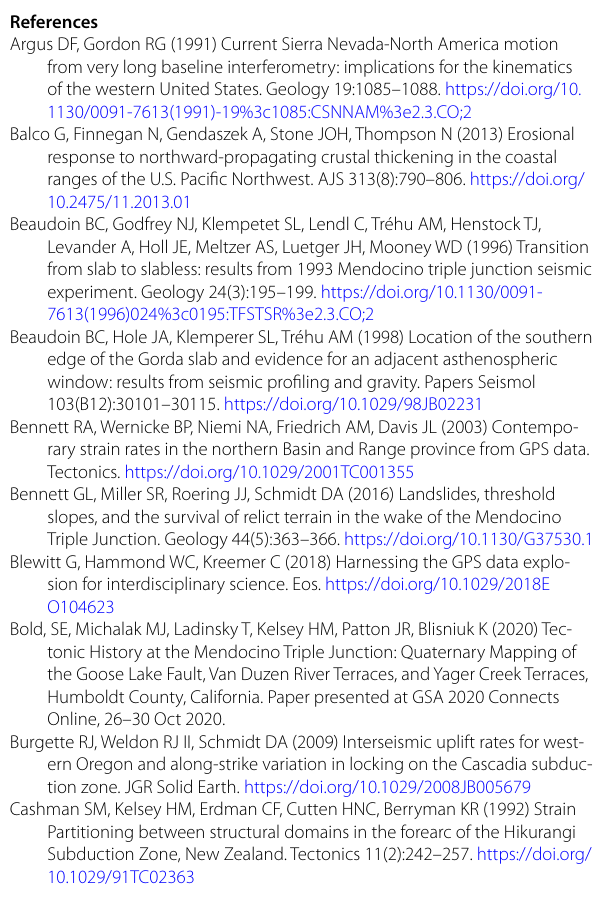
tional file 1: Figure S6 are from the published article McCaffrey et al. (2007) (https:// doi. org/ 10. 1111/j. 1365- 246X. 2007. 03371.x). The finite reconstruction poles used to create Figs. 5 and 6 are from the published articles Wilson (1993) and DeMets and Merkouriev (2016). Maps were produced using GMT (https:// www. gener ic- mappi ng- tools. org/; Wessel et al.